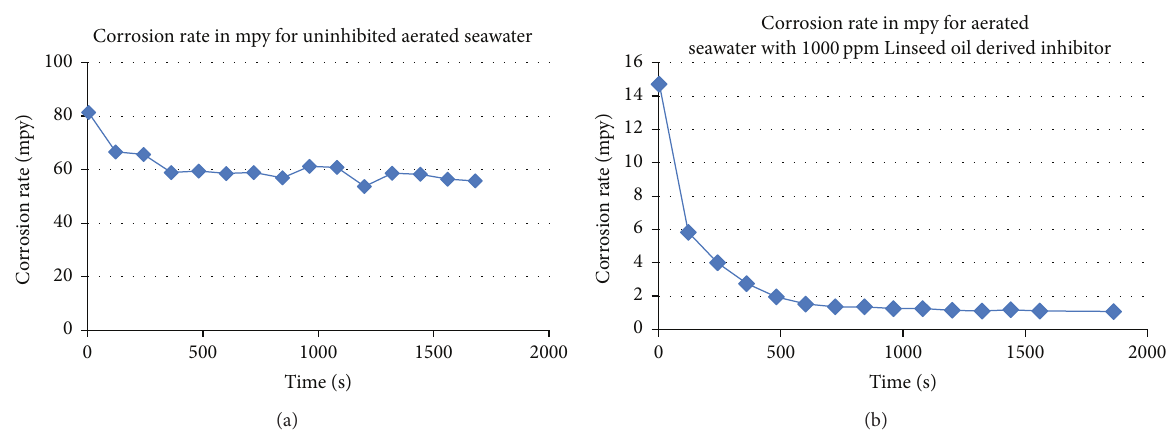
Figure 3: (a) Corrosion rate versus time by linear polarization measurements for uninhibited carbon steel coupon in stirred aerated seawater. (b) Corrosion rate versus time by linear polarization measurements for inhibited carbon steel coupon in stirred aerated seawater. Linseed oil derived inhibitor at 1000 ppm concentration